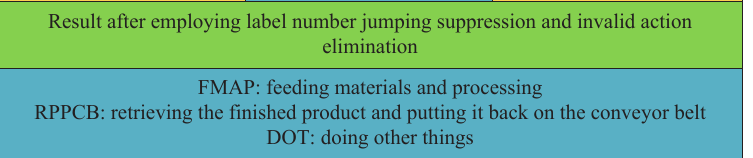
Figure 13. Experimental results of optimal strategy of invalid action elimination.